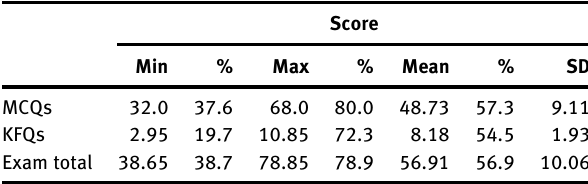
Table  : Participants ’ exam scores distribution (n=  ).